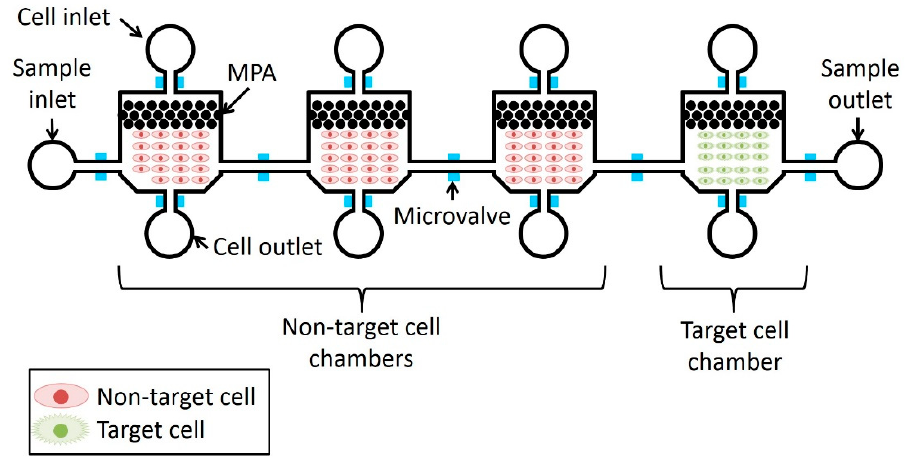
Figure 3. Schematic illustration of the microfluidic device.